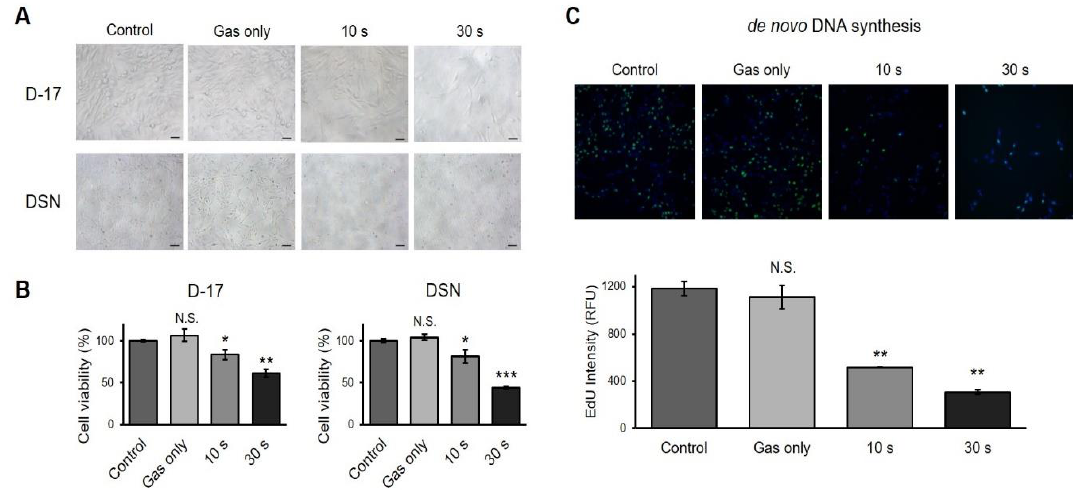
Figure 2. Induction of cell growth arrest by cold atmospheric plasma. ( A ) Representative images of the D-17 and DSN canine osteosarcoma cell lines treated with CAP. Scale bars, 100 μm. ( B ) Cell viability assay. D-17 and DSN cells were exposed to CAP at the indicated time. Cell viability was measured using CellTiter 96 AQ ueous One Solution. Error bars represent the mean ± S.E.M. of three replicates. ( C ). Measurement of de novo DNA synthesis. D-17 cells were stained with 5-ethynyl-2′-deoxyuridine (EdU), which stains the newly synthesized DNA, and the intensity was quantified by high-content screening technology. Green, EdU; and Blue, Hoechest 33342. Error bars represent the mean ± S.E.M. of three replicates. Magnification, 100X. * p < 0.05, ** p < 0.01, *** p < 0.001; N.S. indicates not significant.